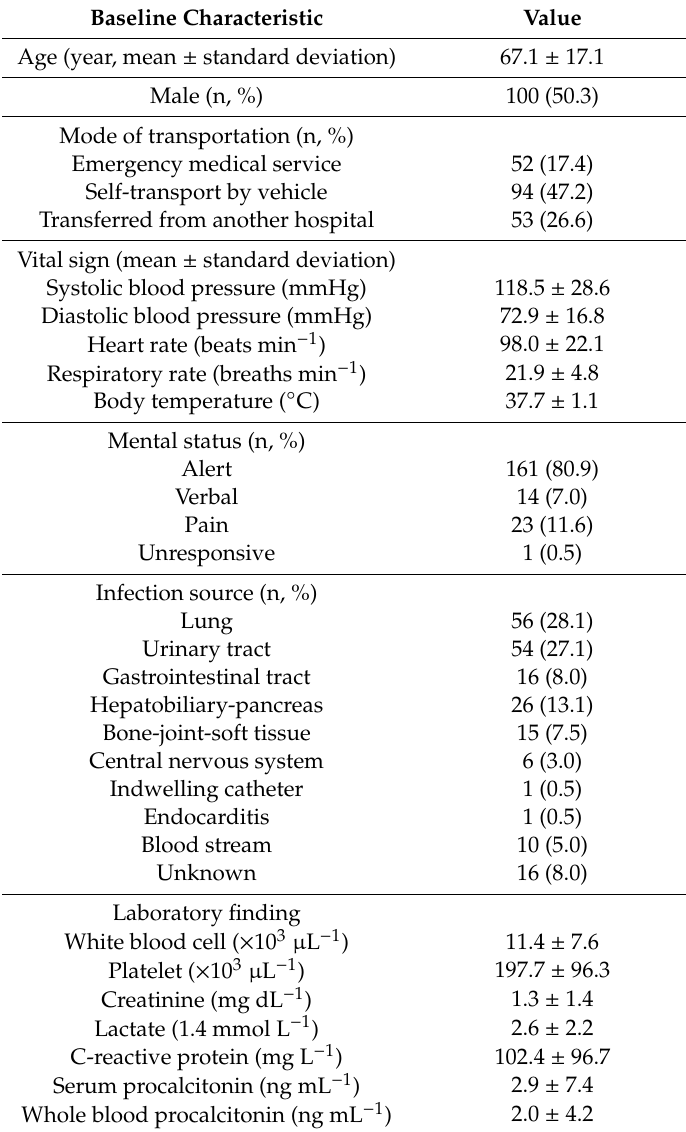
Table 1. Baseline characteristics of study